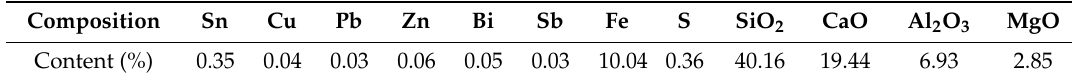
Table 3. Main chemical composition of the test tailings.